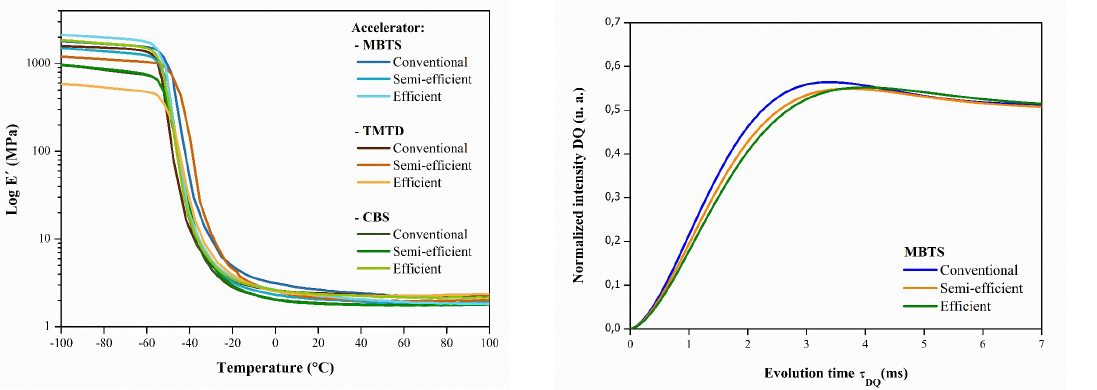
Figure 2. Storage module curves (E’) of NR compounds vulcanized and accelerated by: MBTS, TMTD and CBS in their respective vulcanization systems.